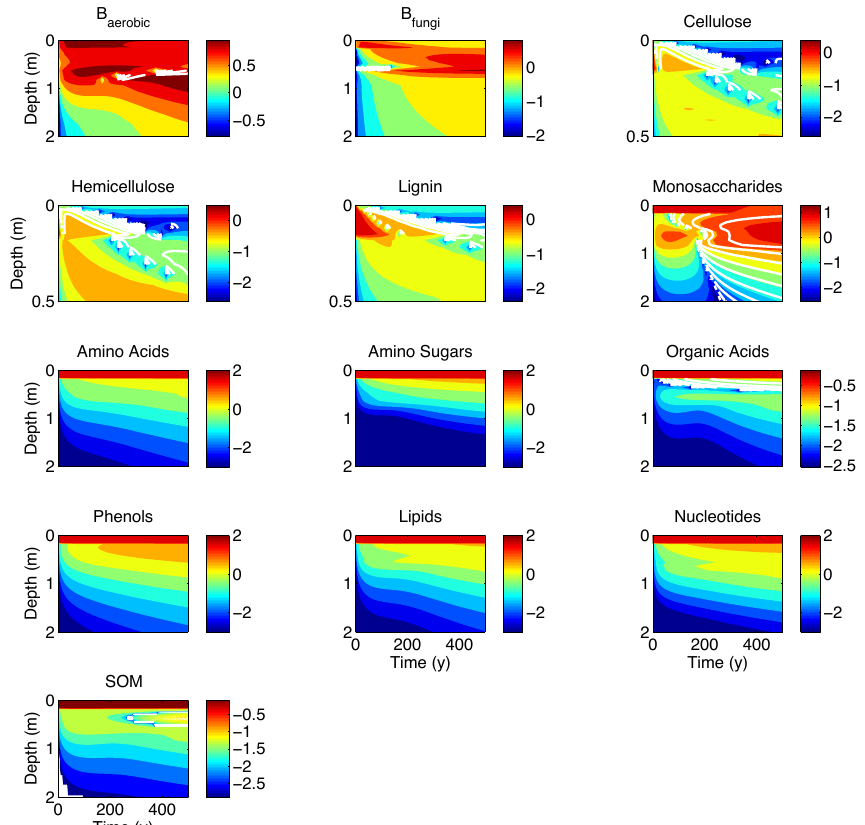
Figure 7. Time and depth profiles of microbial and chemical species concentration anomalies (log10(% | anomaly | ) compared to the baseline simulation) for the perturbation experiment that doubled all chemical species concentrations in the top 20cm of soil as an initial condition. To highlight important features, we: (1) used different ordinate axes for cellulose, hemicellulose, and lignin; (2) excluded anomalies less than 0.001%; and (3) used solid filled contours where the anomalies were positive and white contour lines surrounding regions where the anomalies were negative (e.g., for the monosaccharides below about 20cm after about 200